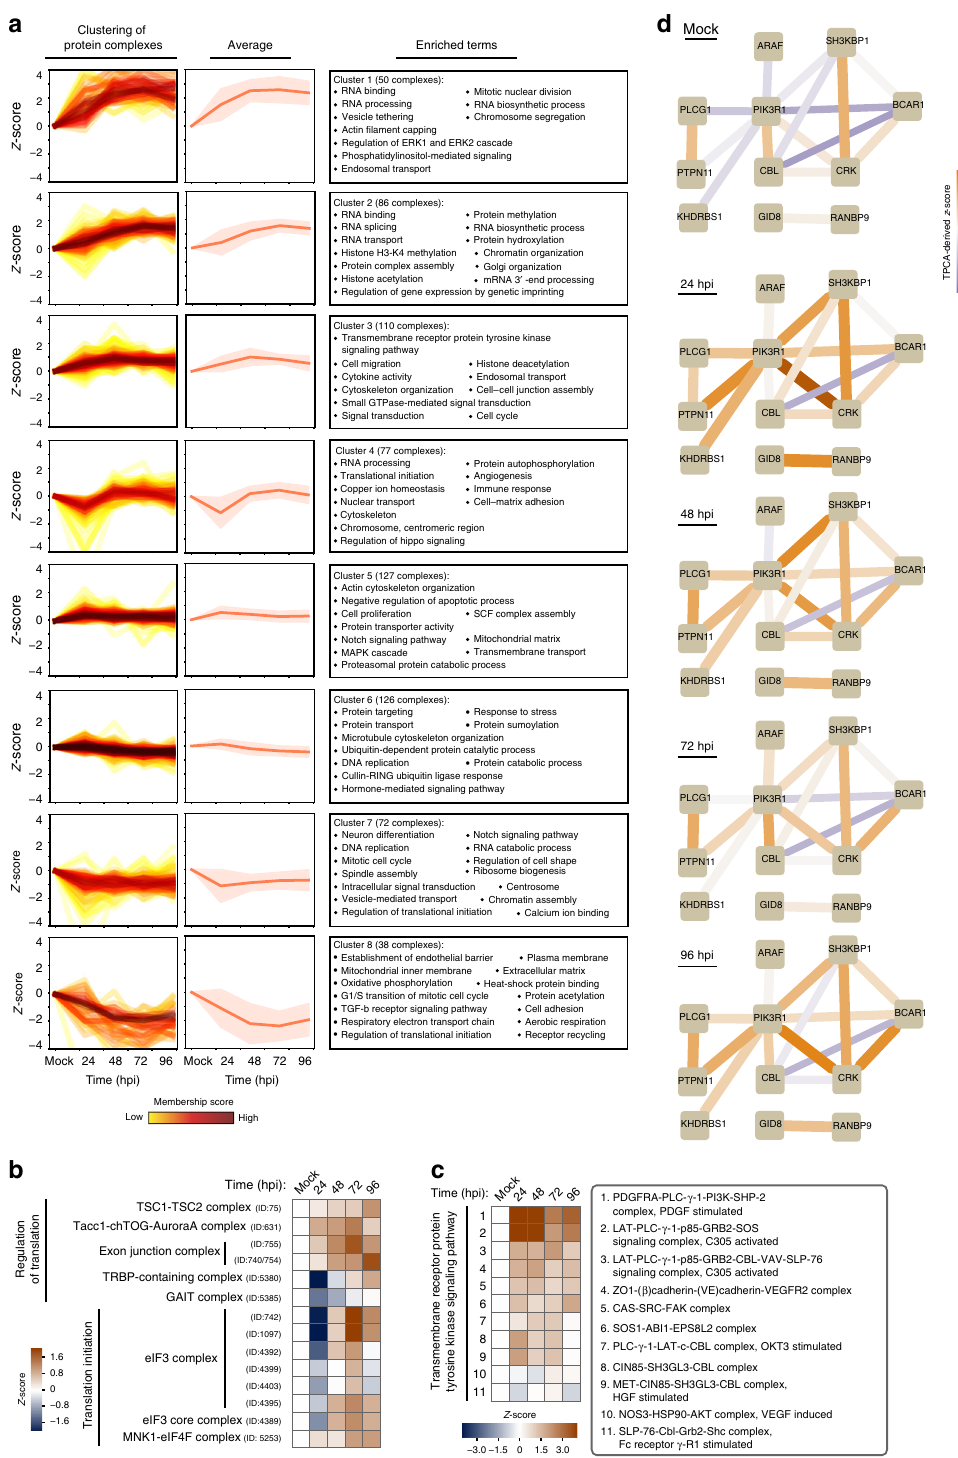
stimulated1. complex4. stimulated8. CIN85-SH3GL3-CBL 9. MET-CIN85-SH3GL3-CBL complex, HGF 11. SLP-76-Cbl-Grb2-Shc complex, Fc receptor γ -R1 Fig. 2 Temporal changes in functional protein complexes point to the stabilization of translation and PI3K signaling pathway complexes during HCMV infection. a (Left) Euclidean distance-based z -score plots shift from mock after infection for CORUM protein complexes. The corresponding z -score represents the number of standard deviations between the average Ex and the mean of the fi tted Gaussian distribution. Protein complexes are clustered by Fuzzy c-means and membership scores are depicted by the color of lines. Membership score represents how close to the center of the cluster a given complex is. Higher membership scores (dark red line) indicate how close the given protein complex is to the average of its corresponding cluster, while lower membership scores indicate larger deviation of the complex from this average. (Middle) Average z -score plot for each cluster (solid line) ±SD (shaded region). (Right) GO terms enriched in each cluster. b Heat map of z -scores for translation-related CORUM protein complexes. c Heat map of z -scores for CORUM protein complexes regulating transmembrane receptor protein tyrosine kinase signaling. d Network plots of the proteins in the PI3K pathway throughout infection. Edge width and color represent transformed Euclidean distance between nodes and the corresponding z -score derived from TPCA,